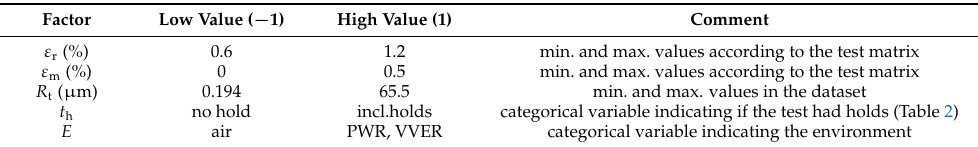
Table 5. Normalization of the factors in the main